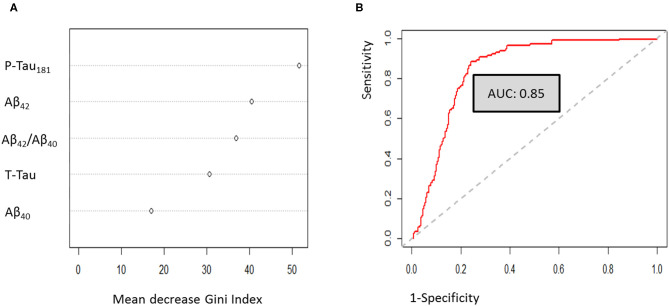
Multivariate analysis using random forest approaches. (A) Gini-Index evaluation for the optimized model. (B) Random forest ROC curve analysis.